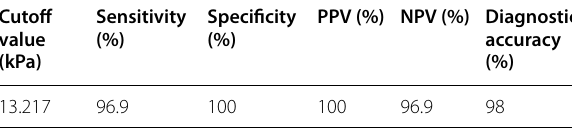
PPV positive predictive value; NPV negative predictive value; kPa kilopascals; SWE shear wave elasticity; AIT autoimmune